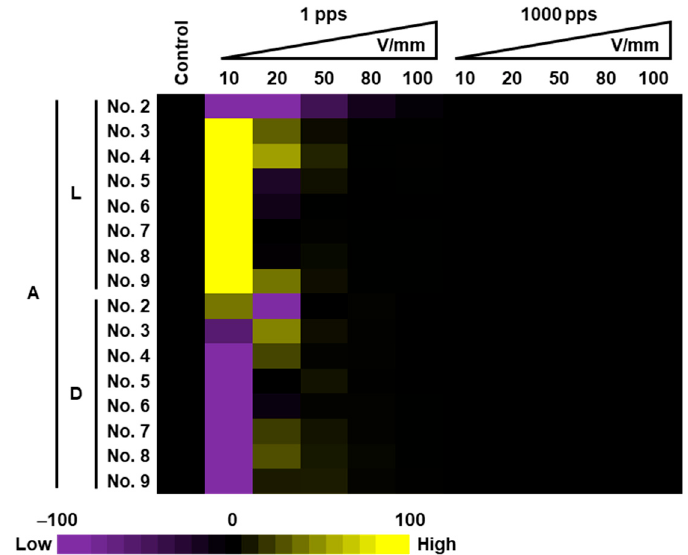
Figure 8. Heatmaps of photosynthetic rate A in the lettuce leaves treated with PEF. Heatmaps were drawn using the total input energy for one lettuce plant divided by the amount of change of A in Figure 7.